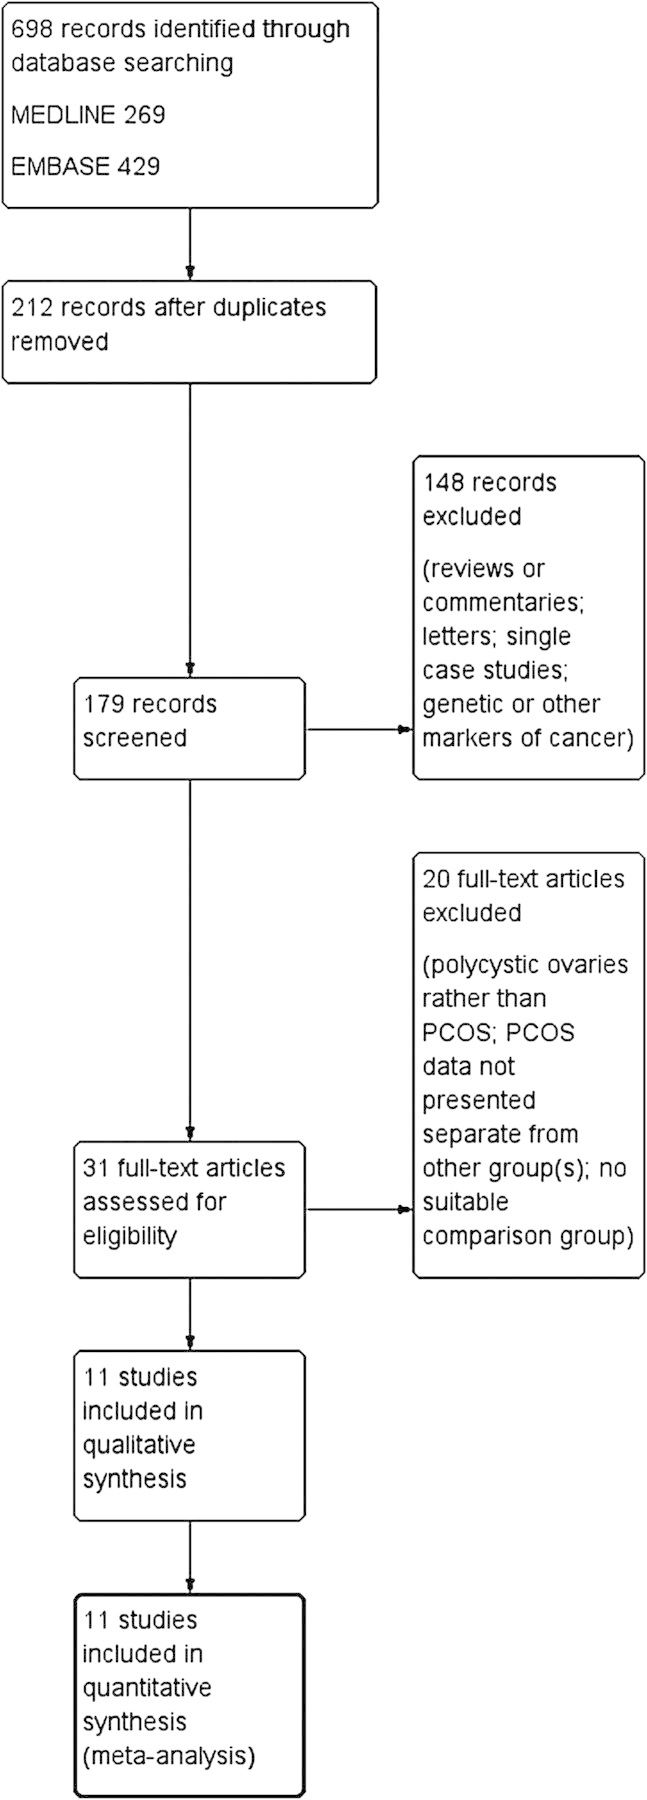
Flow diagram of the literature search for studies of fatal and non-fatal endometrial, ovarian, and breast cancer.